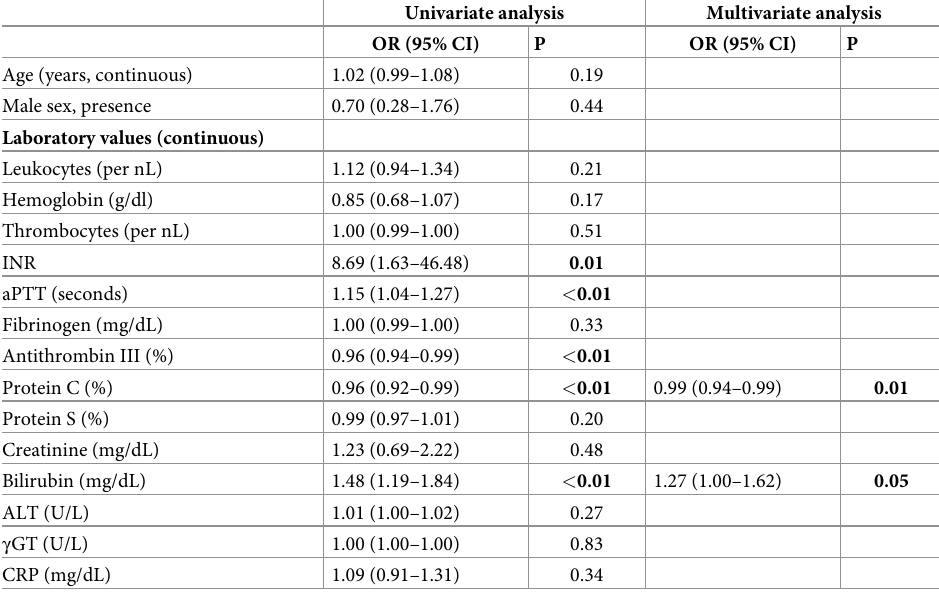
Table 4. Uni- and multivariate analyses of association between different variables and mortality/transplantation in patients with liver cirrhosis.